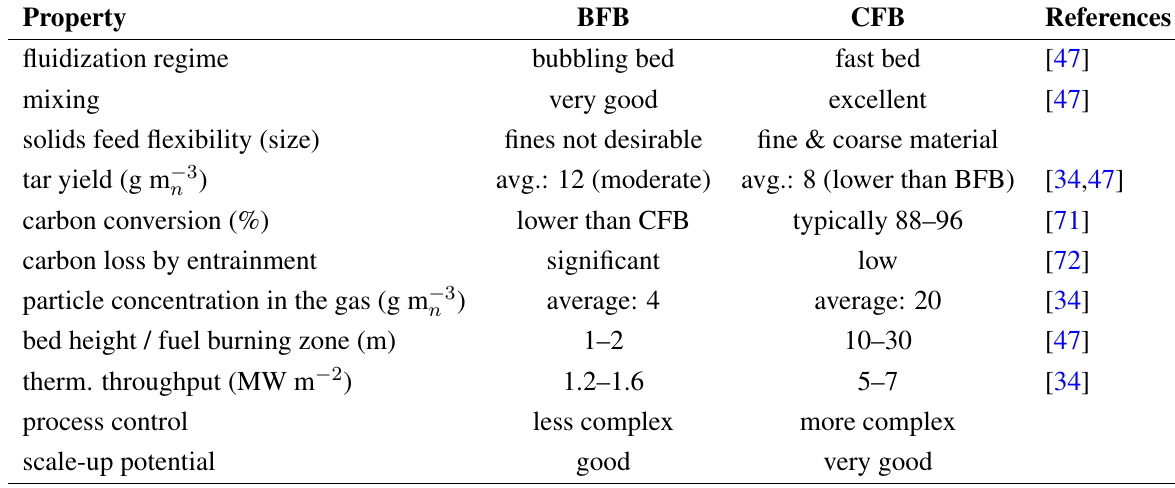
Table 8 . Overview of the differences between a bubbling and a circulating fluidized bed gasifier, constructed on an industrial